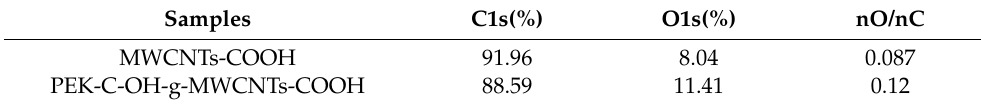
Table 2. The surface element content of MWCNTs-COOH and PEK-C-OH-g-MWCNTs-COOH. Samples